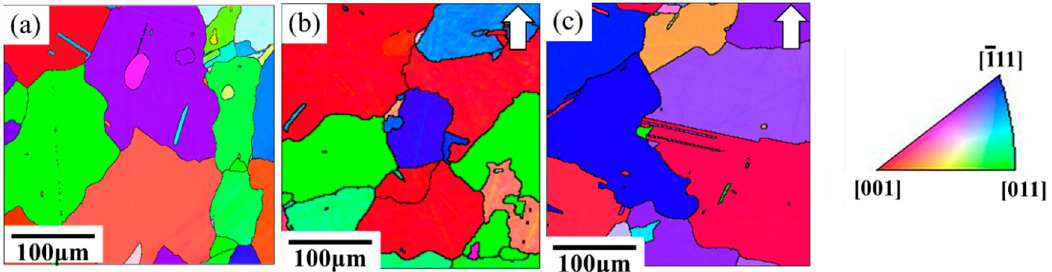
Figure 7. IPF images of ( a ) STA-1180 °C/4 h, ( b ) as-HIPed, and ( c ) HIP+ direct aging specimens were analyzed using the orientation measurements by EBSD. The build directions are shown by arrows.